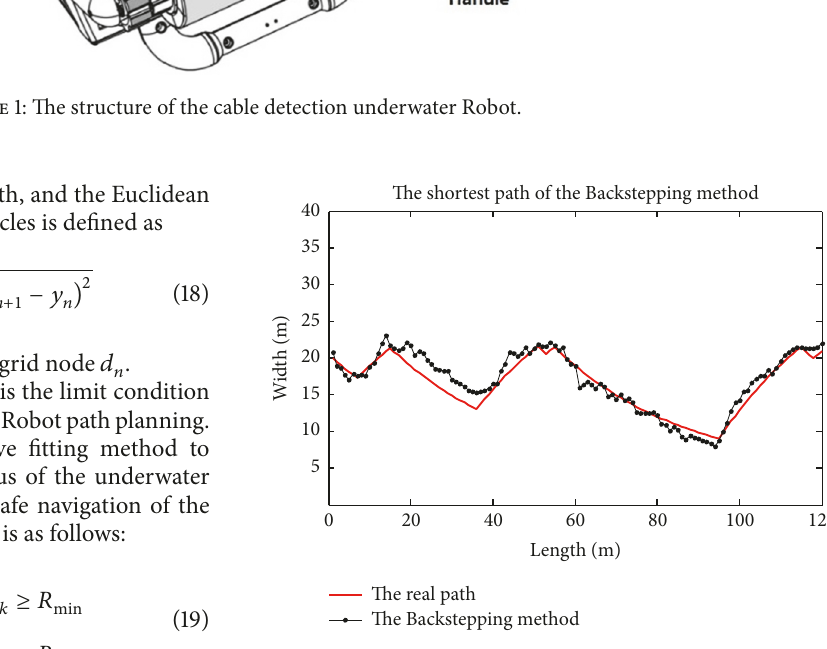
Figure 2: The shortest path of the Backstepping